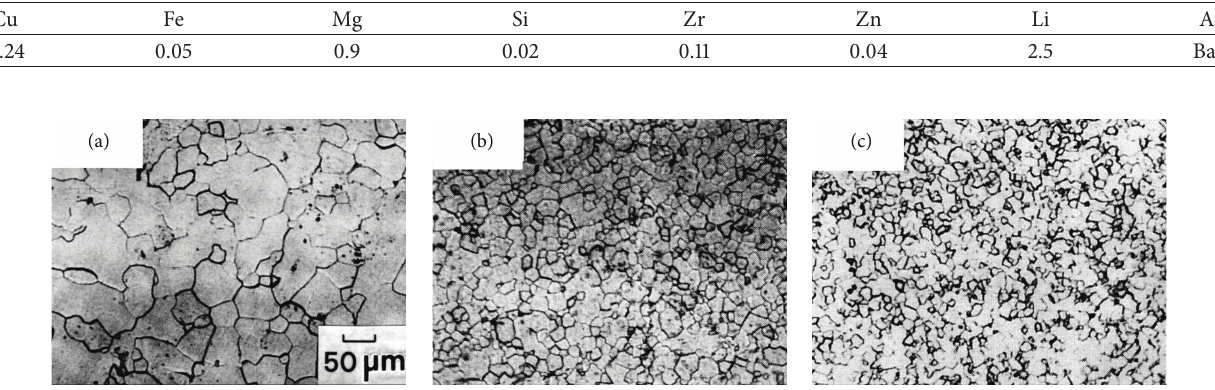
Figure 3: Optical micrographs of thermomechanically treated 8090 Al-Li alloy with the average grain size of (a) 50 𝜇 m, (b) 18 𝜇 m, and (c) 10 𝜇 m,